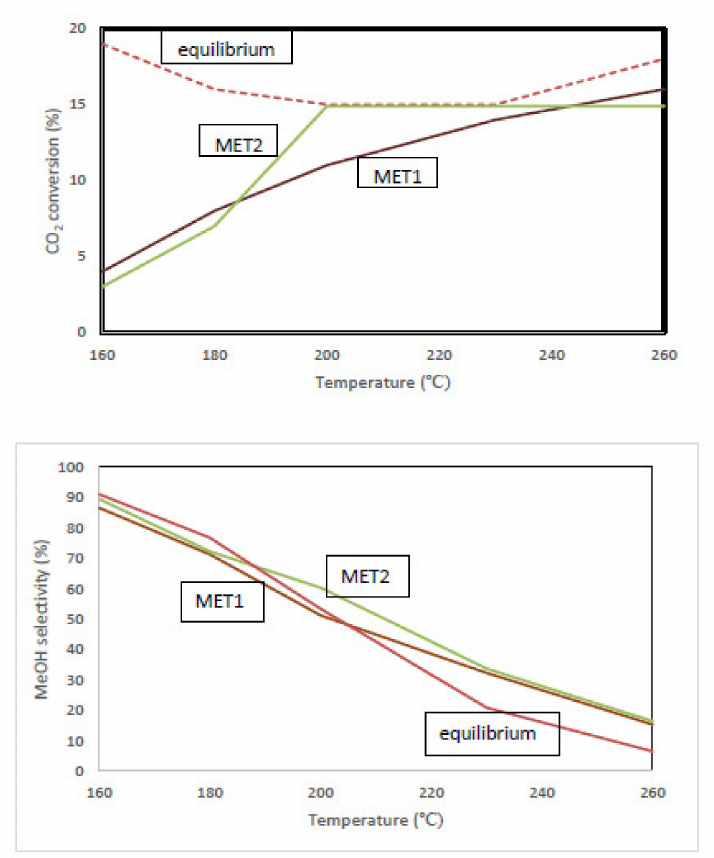
Figure 3. The impacts of reaction temperature on the CO 2 conversion (top) and MeOH selectivity (bottom) for the ultimate selected catalysts and comparing their performances with the thermodynamic-equilibrium limited achievable performance; Reaction conditions: H 2 / CO 2 = 3, T = 160–260 ◦ C, P = 9 bar g, GHSV = 200 h − 1